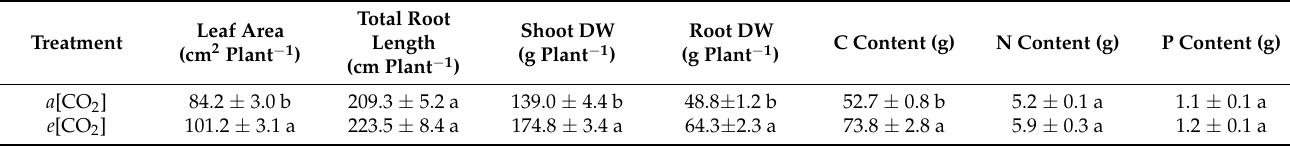
Table 1. Leaf area; total root length; dry weight (DW); and C, N, P content of Phragmites australis grown under ambient ( a [CO 2 ], 400 ppm) and elevated ( e [CO 2 ], 800 ppm) atmospheric CO 2 concentrations. Different small letters mean significant difference at p < 0.05 level. Data are expressed as means ± SEM (n = 3). Leaf Area (cm 2 Treatment